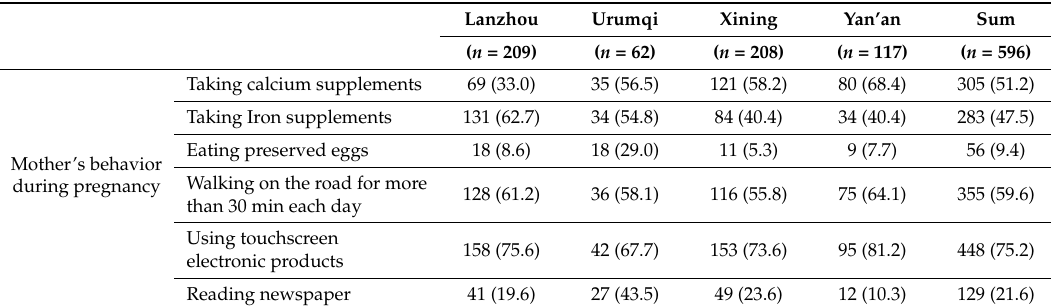
Table 11. Mothers’ behavior during pregnancy in different